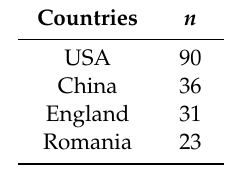
Table 9. Most cited articles.